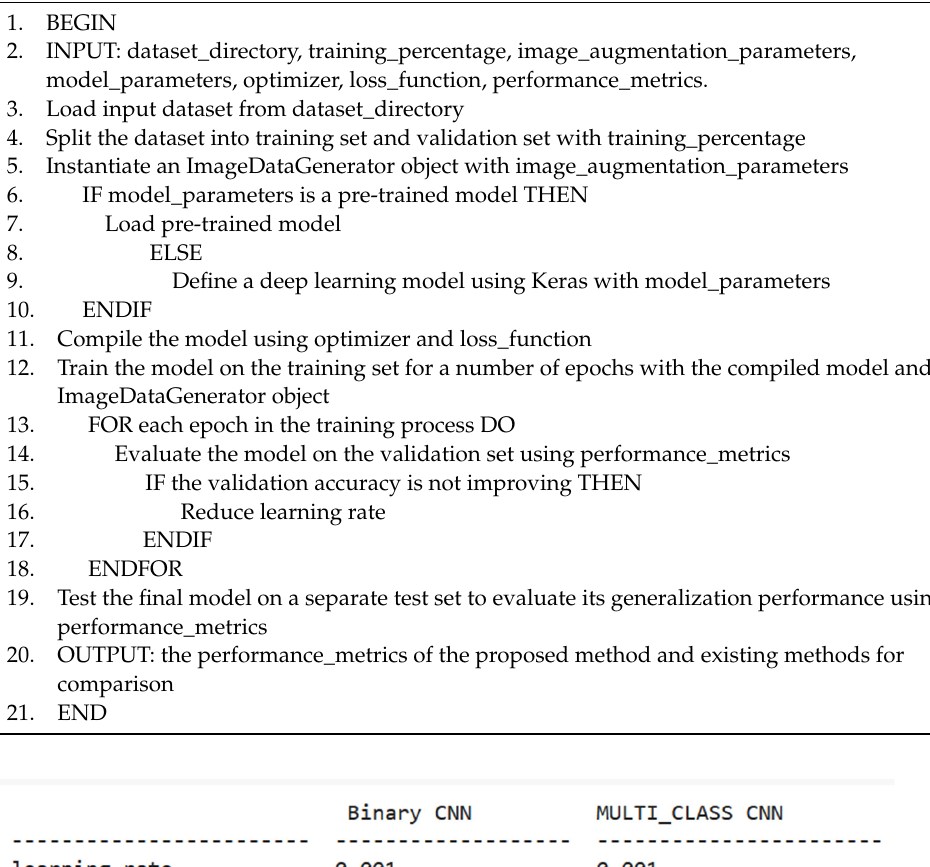
Algorithm 1: The proposed algorithm (Summary of the proposed model)